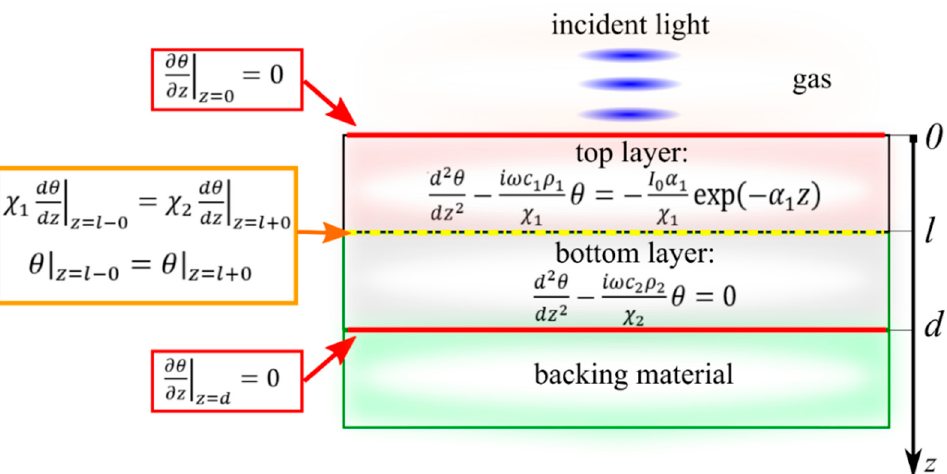
Figure 3. Cross-sectional view of the model characterized by heat conduction equations for each layer with the corresponding boundary conditions. The location of the layer under investigation depends on the configuration of the PA cell; the top layer is assigned in the case of front-surface illumination configuration, and the bottom layer is assigned in the case of rear-surface illumination configuration; α is the optical absorption coefficient, and ω is a cycling frequency.